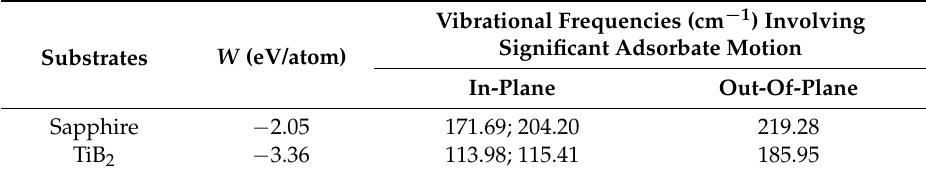
Table 2. Adsorption energy and the vibrational frequencies of the single Al adsorbed (0001) sapphire and (0001) TiB 2